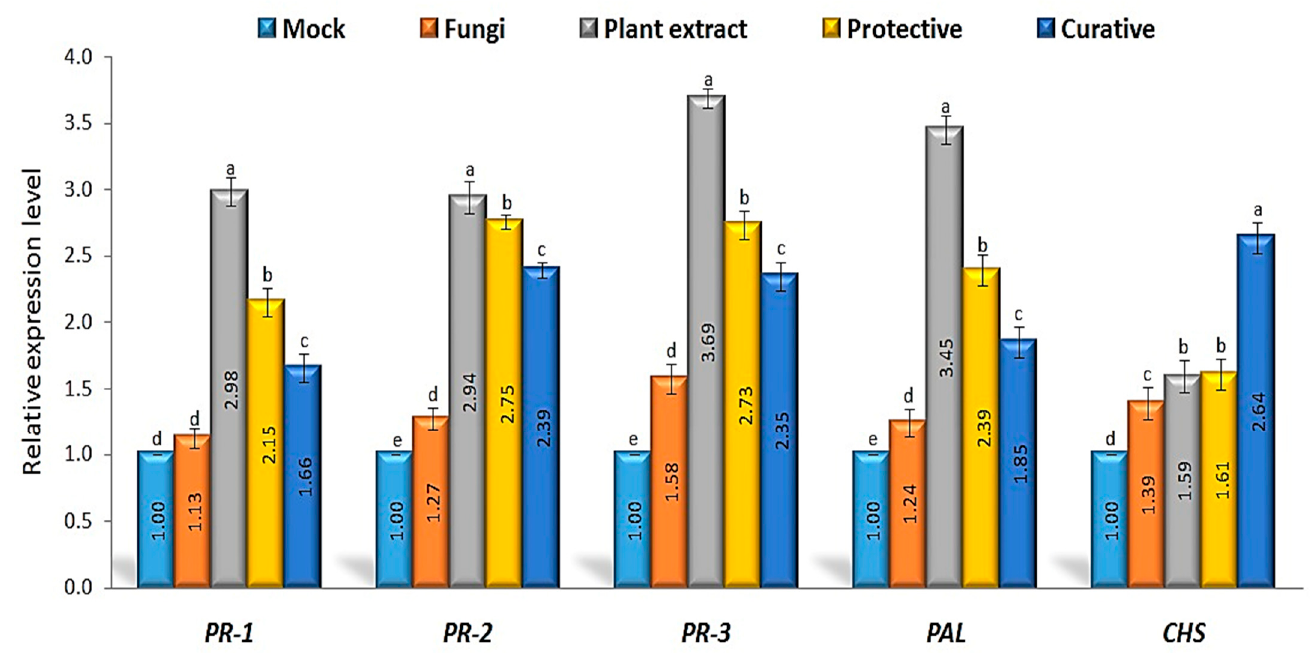
Figure 5. Relative expression levels of five genes: PR-1 , PR-2 , PR-3 , PAL, and CHS at 20 dpi. The different letters on top of the columns mean the data values were significantly different in each gene at p ≤ 0.05.